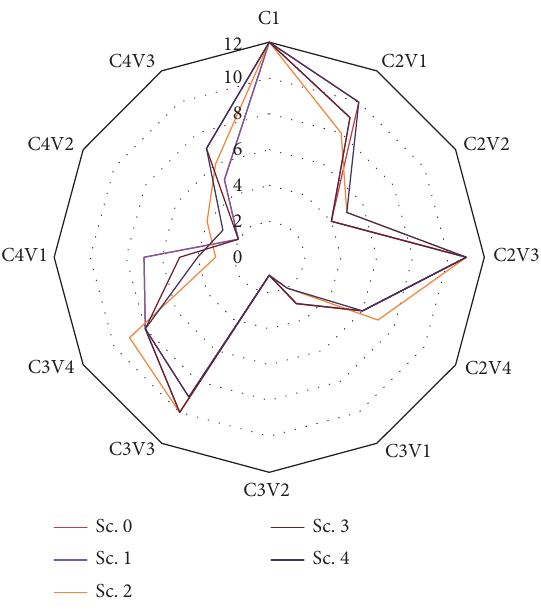
Figure 5: Sensitivity